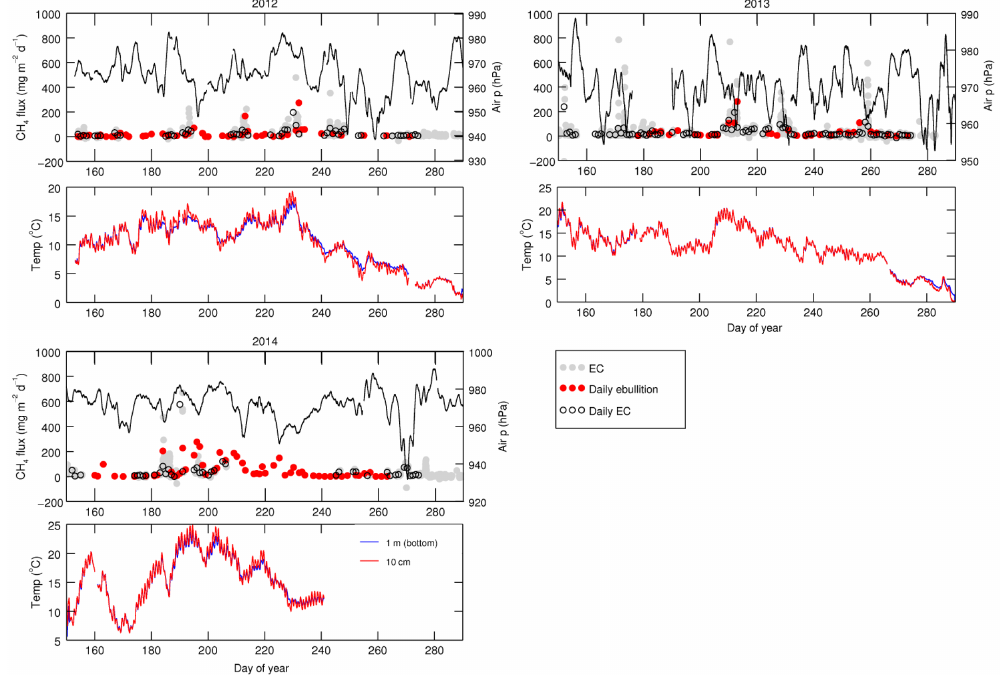
Figure 6. CH 4 emissions at the lake during the ice-free seasons of 2012, 2013, and 2014, from day 152 to day 290. Grey dots are half-hourly eddy covariance observations, open black dots are daily means of the eddy covariance fluxes, and red dots show spatially averaged daily CH 4 ebullition measured in the lake with bubble traps. Atmospheric pressure (black line), and water temperature at depths 10cm (red line) and 100cm (sediment surface, blue line) are also shown.